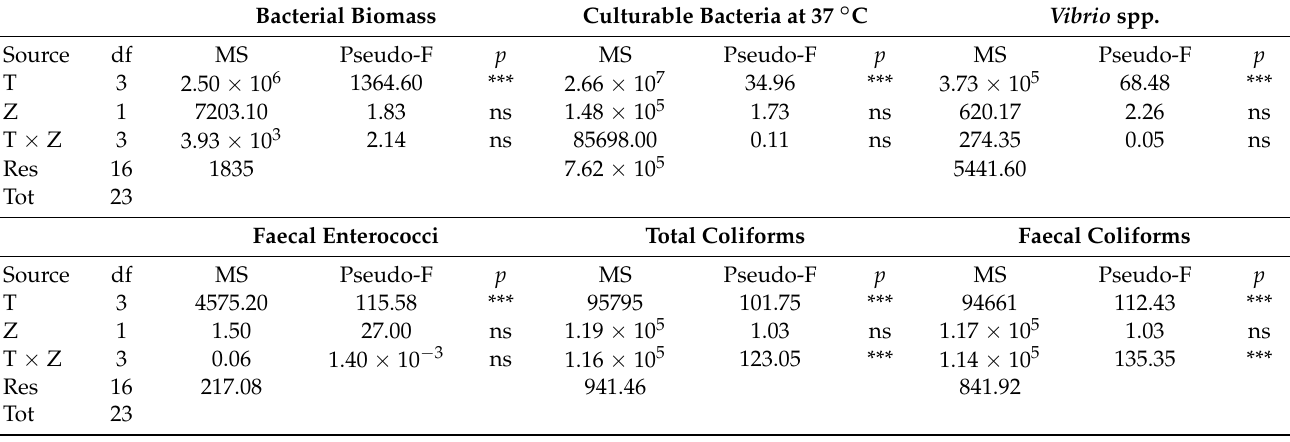
Table 4. Results of the permutational analyses (PERMANOVA) on bacterial biomass, Vibrio spp., culturable bacteria at 37 ◦ C, faecal enterococci, and faecal and total coliforms in the W and E zones (Z) among sampling times (T). Abbreviations: Res—residual; Tot—total; df—degrees of